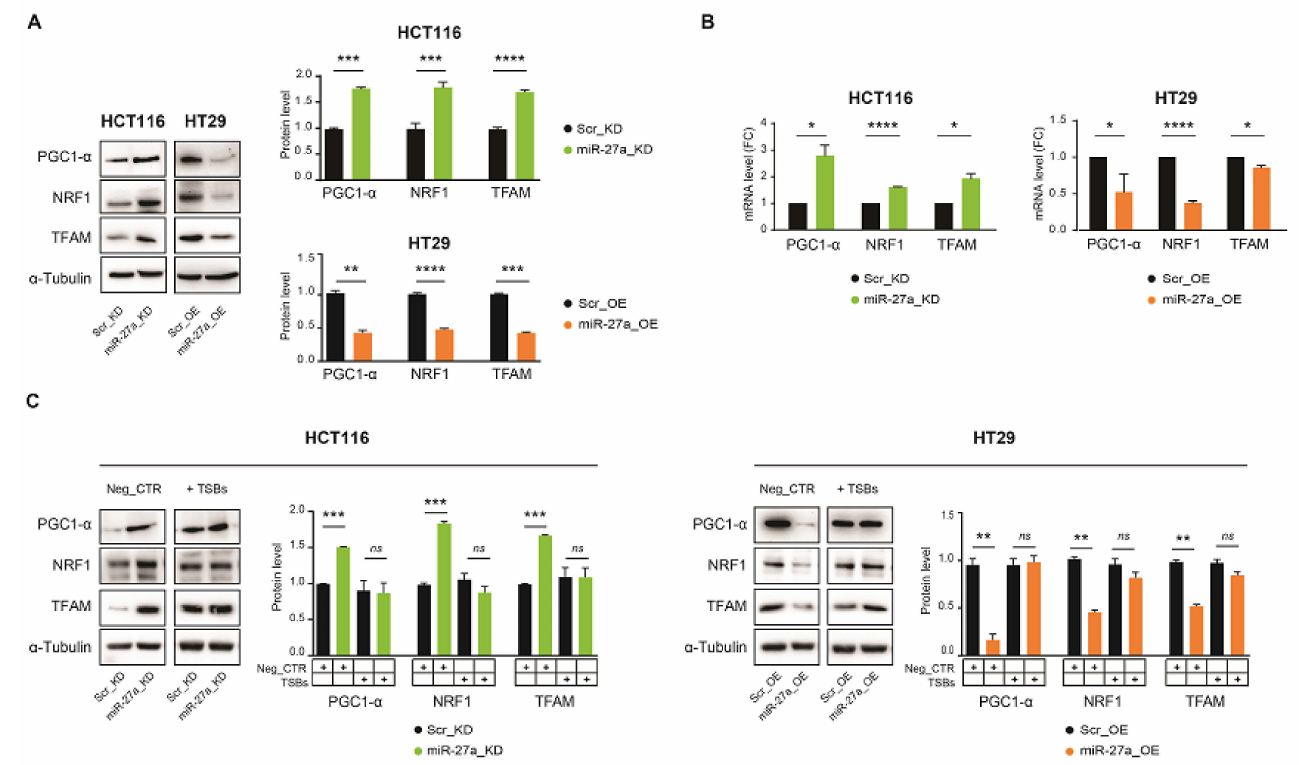
Figure 2. The miR-27a/FOXJ3 axis affects mitochondrial biogenesis. ( A ) Immunoblot and ( B ) qRT-PCR analysis of PGC1- α , NRF1, and TFAM as mitochondrial biogenesis markers in miR-27a_KD and miR-27a_OE cells with respect to their relative Scr_KD and Scr_OE controls in basal conditions. ( C ) Assessment of the same markers as in ( A ) after the transfection of the TSBs or the Neg_CTR. The results shown in ( A ) and ( C ) are representative of at least two performed experiments, normalized to the mean ± SEM, and expressed as protein levels with respect to α -tubulin as a loading control. The α -tubulin shown is from a representative experiment. Statistical significance was considered when * p ≤ 0.05, ** p ≤ 0.01, *** p ≤ 0.001, or **** p ≤ 0.0001 ( t -test); ns = not significant. File S1: Original Western